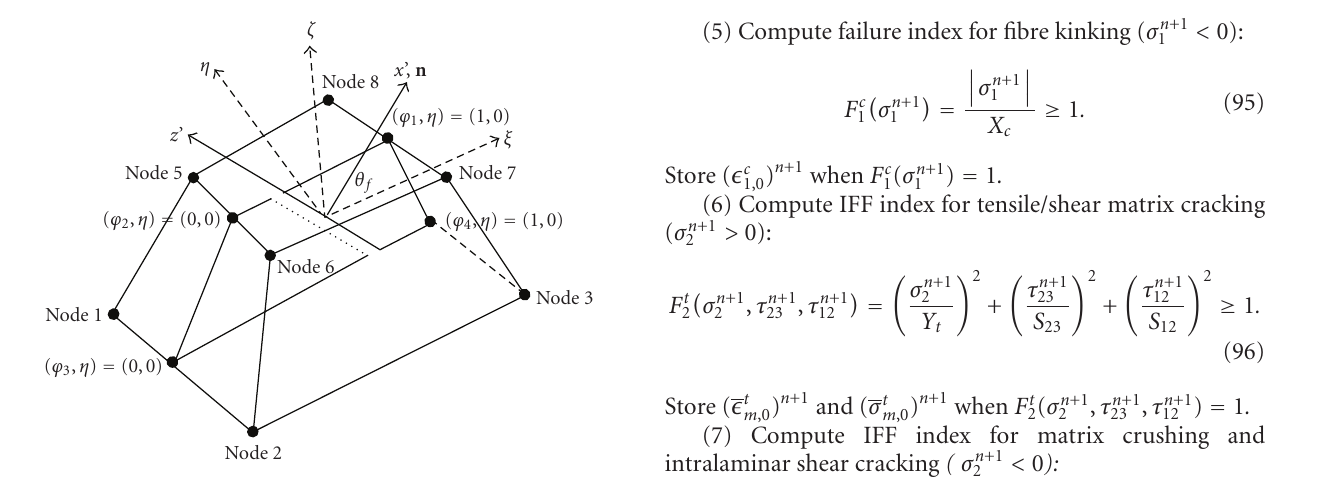
Figure 5: Computation of the characteristic length for transverse